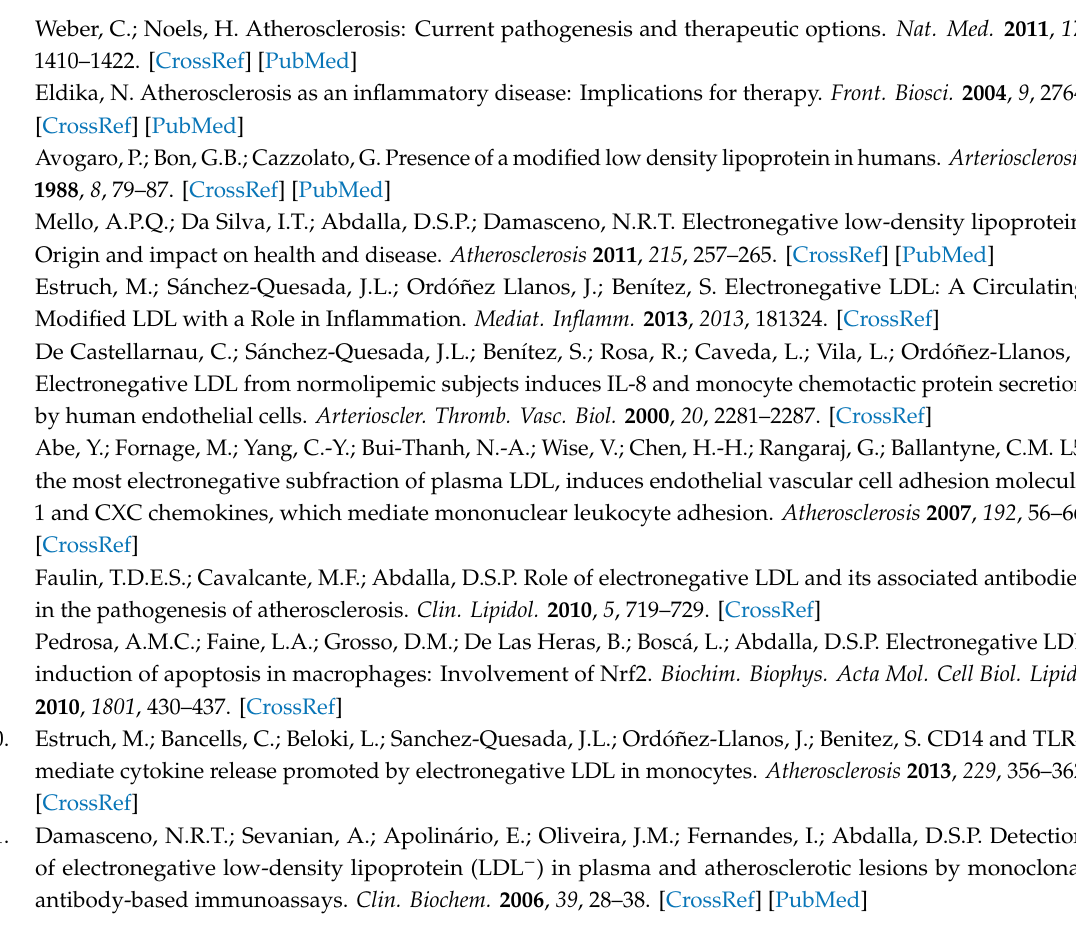
fusion after purification; Figure S5. Western blot analysis with peptides-pIII; Figure S6. Macrophage di ff erentiation; Figure S7. E ff ect of LPS on mRNA expression in bone marrow-derived macrophages evaluated with qPCR; Figure S8. M2 macrophage phenotype. Table S1. Parameters obtained from the IFT fitting; Table S2. Parameters obtained from the model fitting assuming circular ring; Table S3. Primers